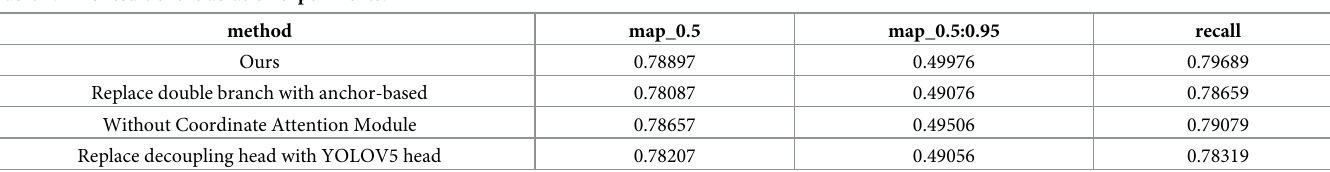
Table 2. The result of the ablation